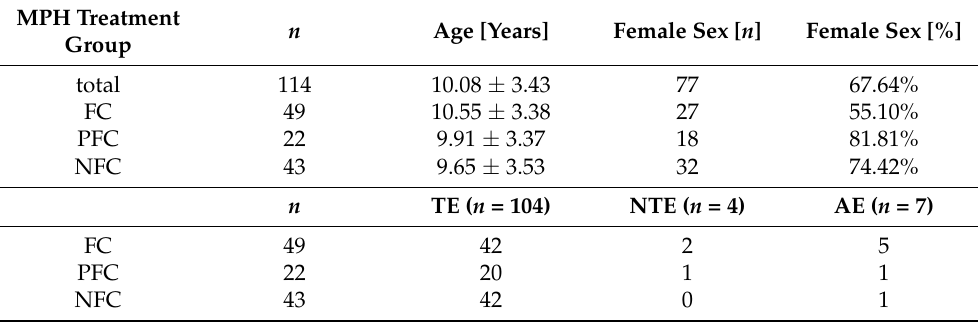
Table 6. Demographic data of patients with MPH medication involved in the study.